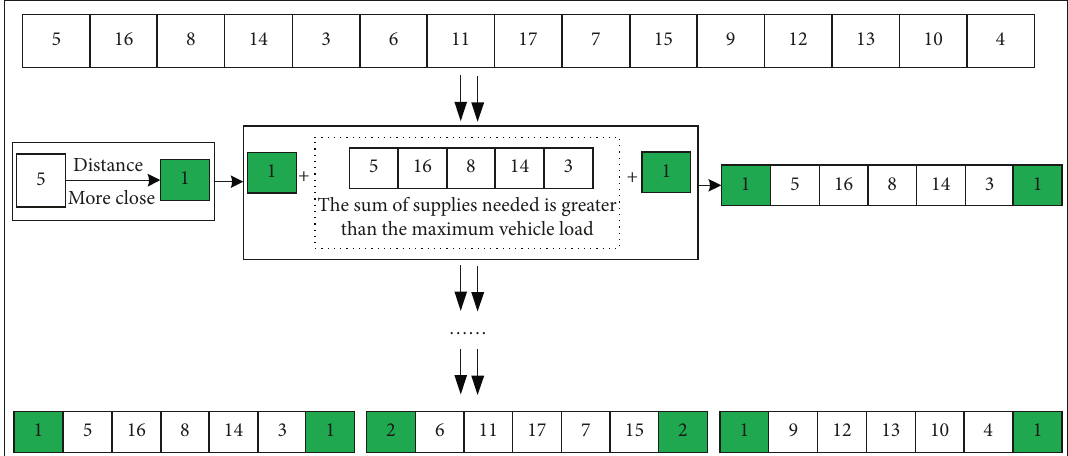
Figure 4: An example of the coding